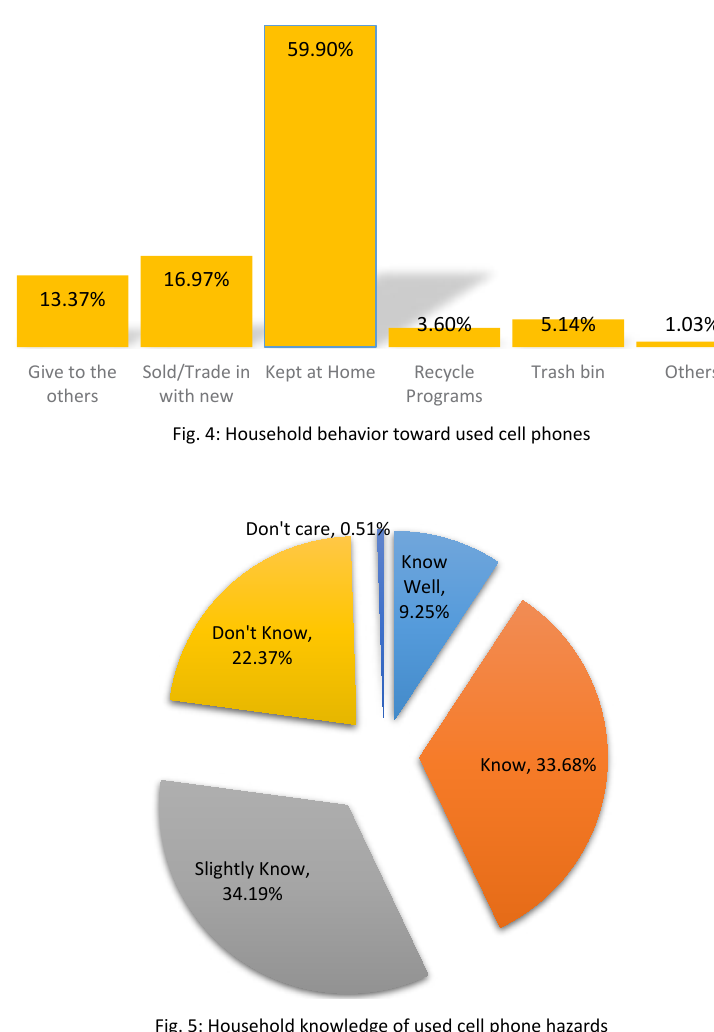
Fig. 5: Household knowledge of used cell phone Fig 5: Household knowledge of used cell phone hazards